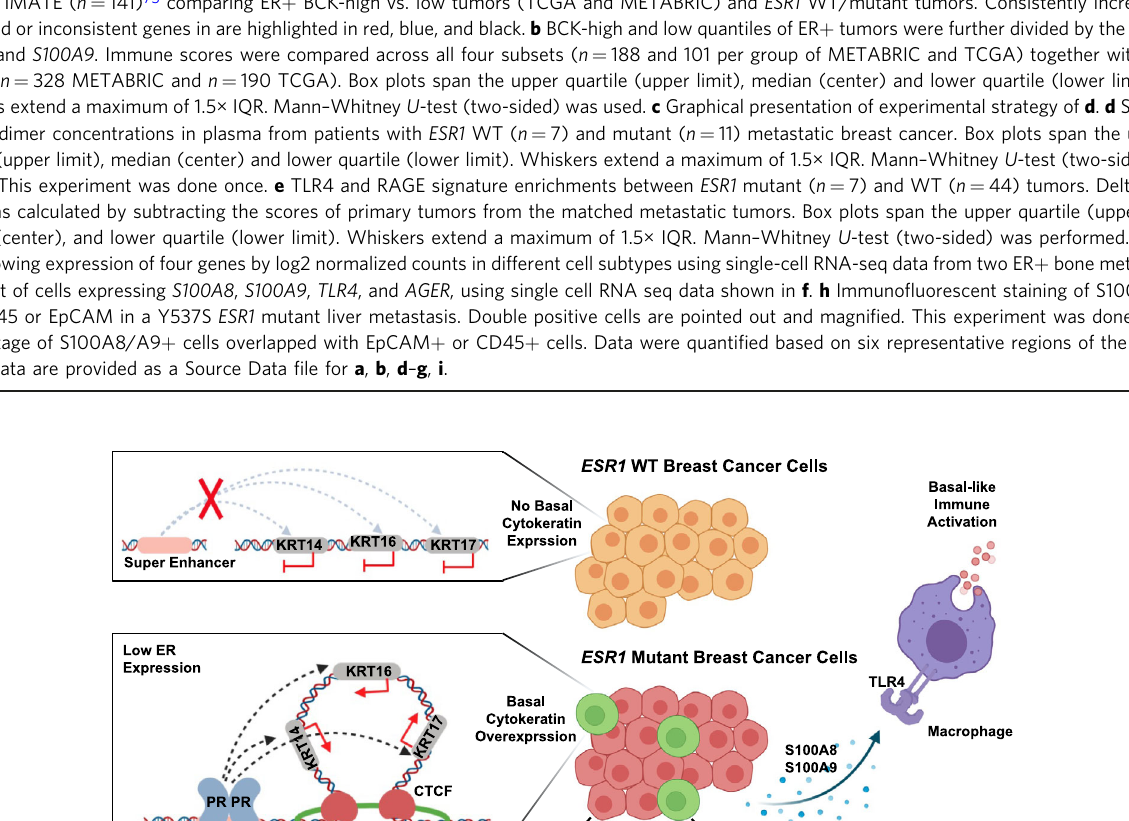
Fig. 7 Graphical presentation of proposed mechanisms and relevance of basal cytokeratin induction in ESR1 mutant breast cancer. ESR1 WT cells exhibit low basal cytokeratin expression with baseline insulated neighborhood prevalence spanning KRT14 / 16 / 17 loci. In contrast, a minor subpopulation of ESR1 mutant cells exhibit strong basal cytokeratin expression, due to PR activated enhancer at the KRT14 / 16 / 17 gene locus-spanning insulated neighborhoods. Increased expression of basal cytokeratin is associated with immune activation in ESR1 mutant tumor similar to that seen in basal tumors, at least in part mediated via enhanced S100A8/A9-TLR4 paracrine crosstalk between epithelial and stromal cells, including macrophages. Figure is generated using